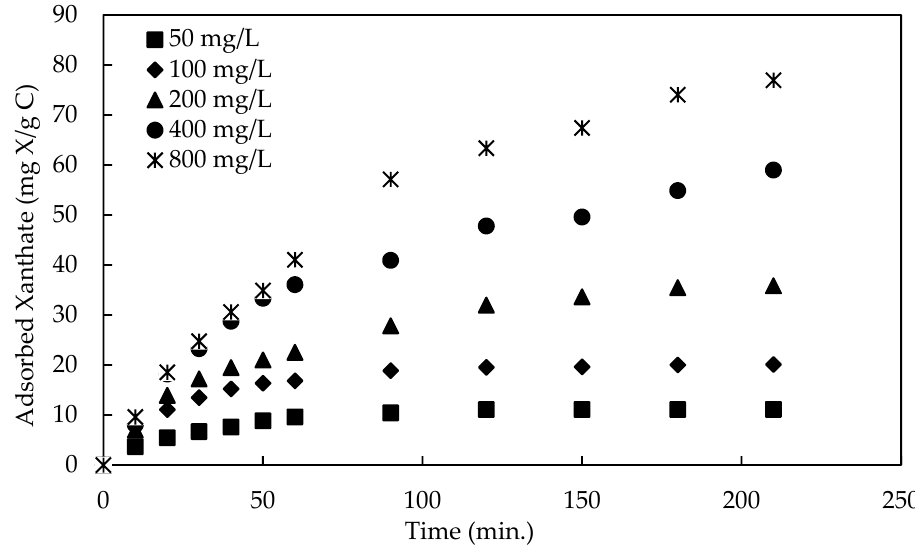
Figure 4. Effect of contact time and initial concentration on the adsorption process of xanthate on activated carbon; agitation speed, 200 rpm; the volume of xanthate solution, 100 mL; the amount of activated carbon, 0.5 g.